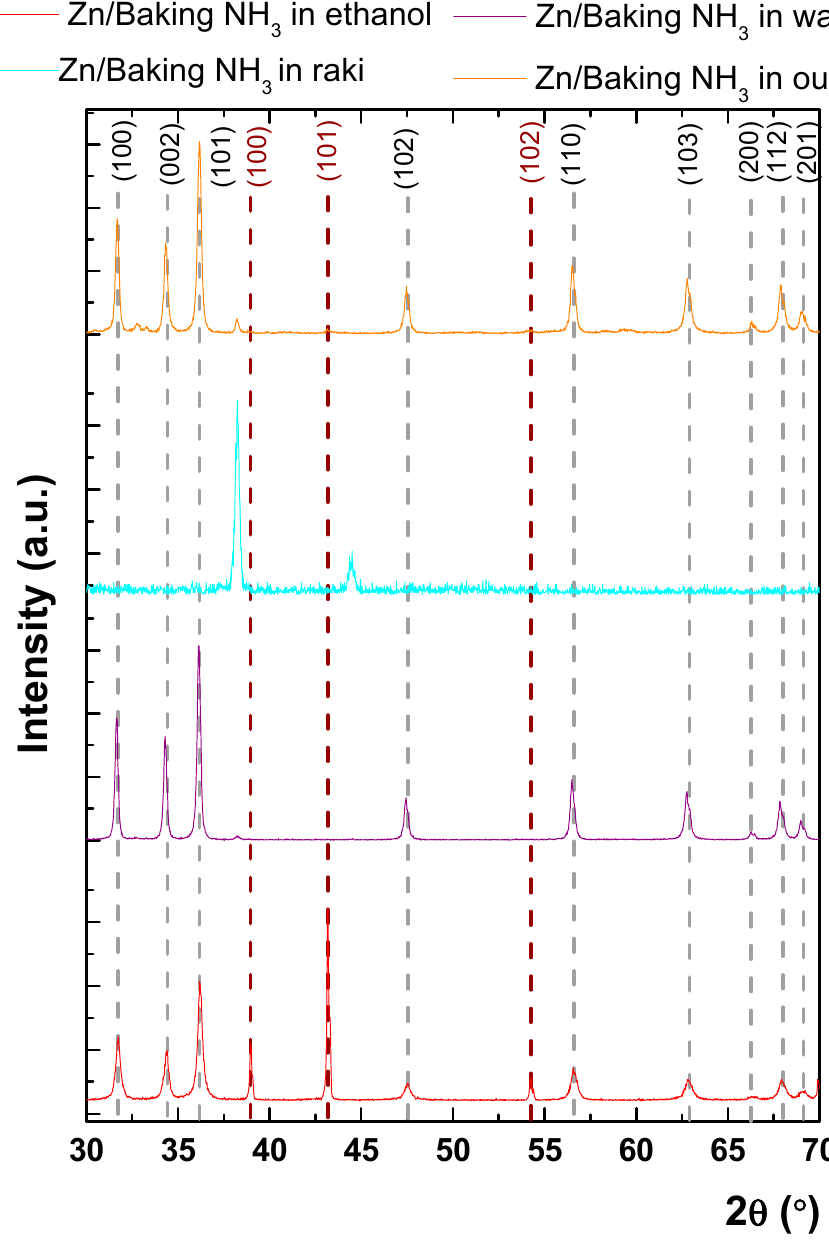
Figure 5. XRD for ZnO nanostructured coatings synthesized starting from zinc powder and baking NH 3 in ethanol (red line), water (violet), raki (blue), and ouzo (orange). The dashed grey line was used to show the position of ZnO diffraction peaks, while the brown one was used for metallic Zn.